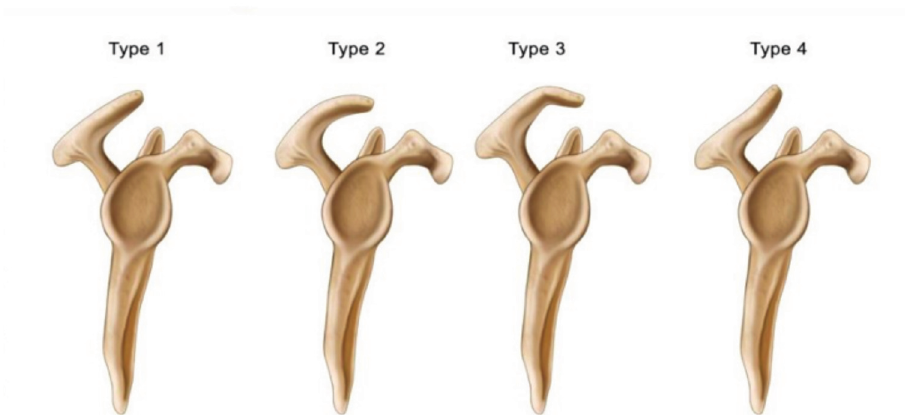
Fig. 1: Illustration showing modified Bigliani’s classification.